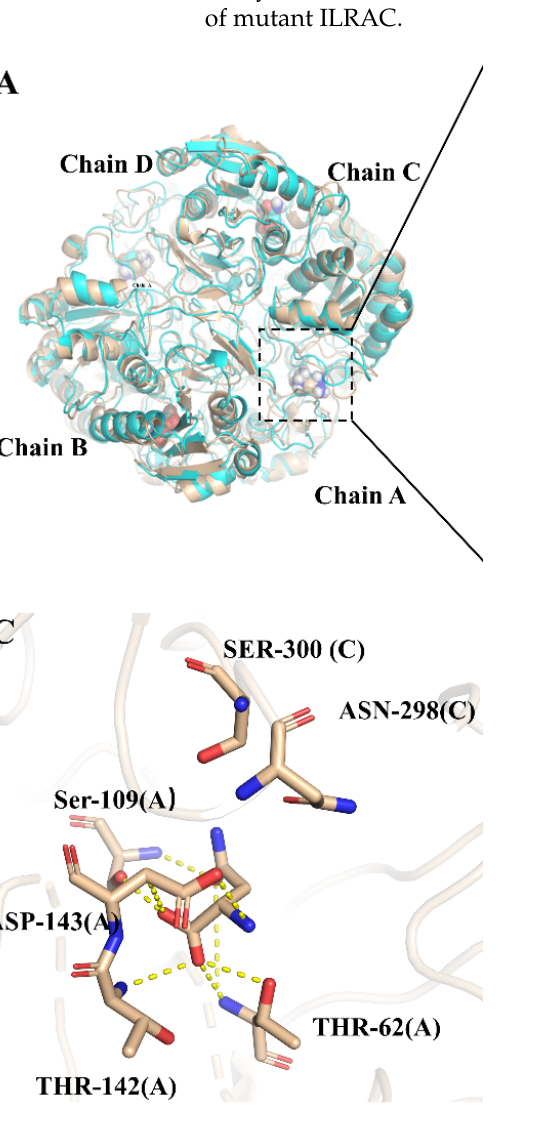
Figure 7. ( A , B ) Substrate binding pocket of wild-type and mutant ILRAC. ( C , D ) Change in the res- idue interactions around the 223rd residue. ( E , F ) Change in the residue interactions around the 325th residue.